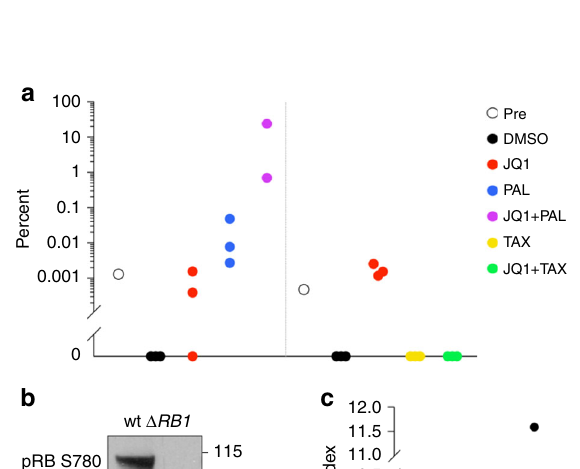
Fig. 3 Mathematical modeling of resistance to JQ1 and palbociclib. a Design of the two-type birth-death process to model barcode evolution during treatment with JQ1 or palbociclib. See Methods for model details. b Experimentally determined growth and death rates used in the model. Source data are provided as a Source Data fi le. c Heatmap of likelihood scores for each pair of parameters tested to simulate cell populations passaged in JQ1. d Comparison between simulated data and experimental data of Shannon indices for cells passaged in JQ1, for the best- fi t value of ρ and various values of μ . Data are represented as mean ± SD, n = 3. e Comparison between simulated data and experimental data of proportions of top barcodes ( x -axis) that are unique, shared between two replicates, or shared between all three replicates at the last passage, with the best- fi t parameters for JQ1. Simulated distributions are represented as mean ± SD, n = 5 independent simulations with three replicates each. f Heatmap of likelihood scores for each pair of parameters tested to simulate cell populations passaged in palbociclib. g Comparison between simulated data and experimental data of Shannon indices for cells passaged in palbociclib, for the best- fi t value of ρ and various values of μ . Data are represented as mean ± SD, n = 3. h Comparison between simulated data and experimental data of proportions of top barcodes ( x -axis) that are unique, shared between two replicates, or shared between all three replicates at the last passage, with the best- fi t parameters for palbociclib. Simulated distributions are represented as mean ± SD, n = 5 independent simulations with three replicates each.